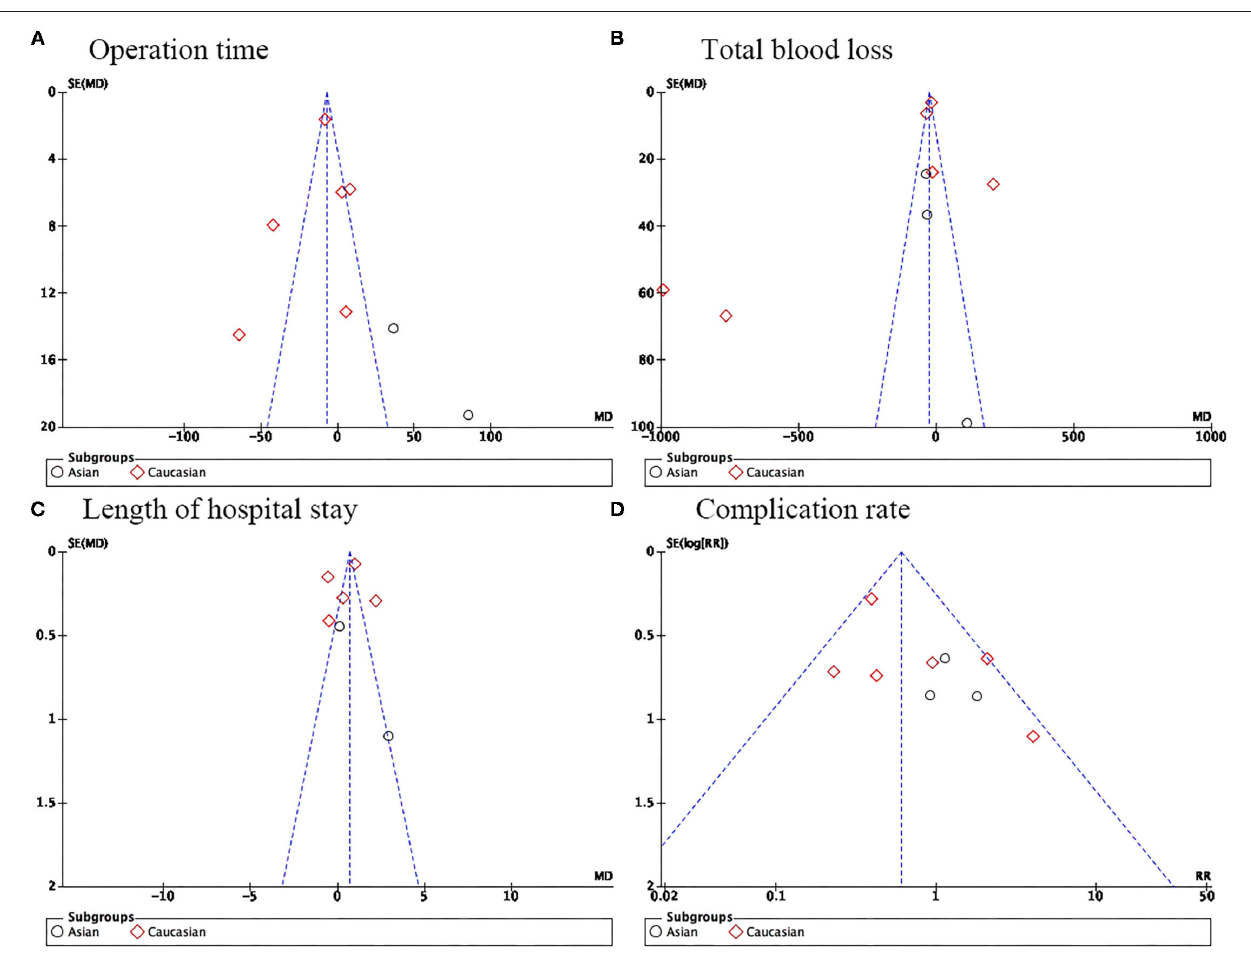
FIGURE 4 | Begg’s funnel plot of publication bias testing for the association of (A) operation time, (B) total blood loss, (C) length of hospital stay, and (D) complication rate in robotic-assisted vs. conventional laparoscopy for para-aortic lymphadenectomy in gynecological